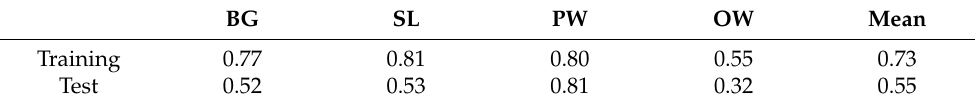
Table 11. IoU scores for Soybeans in Experiment A.